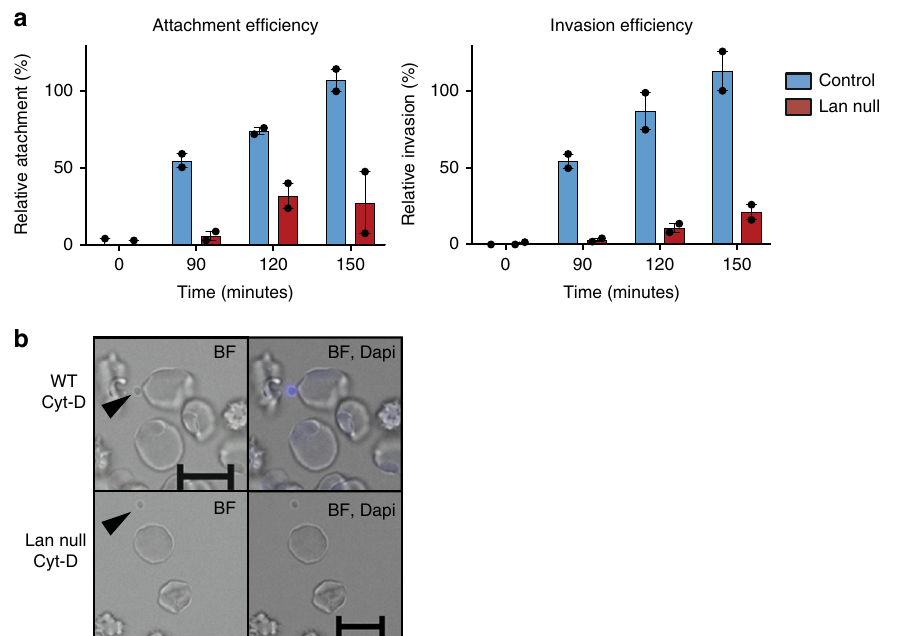
Fig. 3 Attachment of P. falciparum to erythrocytes is dependent on ABCB6. a Mature P. falciparum strain 3D7 schizonts were added to normal wt (blue) or Lan null (red) erythrocytes in the presence of 1 μ M cytochalasin-D to measure attachment or in the absence of cyt-D to measure invasion. Attachment and invasion were measured by SYBR green I staining and fl ow cytometry. Measurements were obtained every 30 min to account for progressive rupture of schizonts, and normalized for attachment/invasion measured in the presence of heparin, n = 2. Data represent the average of two biological replicates ±S. E.M. Values are expressed as relative to the attachment or invasion measured for a control sample at T = 150 min. b Representative images from attachment assay in the presence of Cyt-D showing wt or Lan null erythrocytes and P. falciparum merozoites (arrows). Scale bars = 10 μ